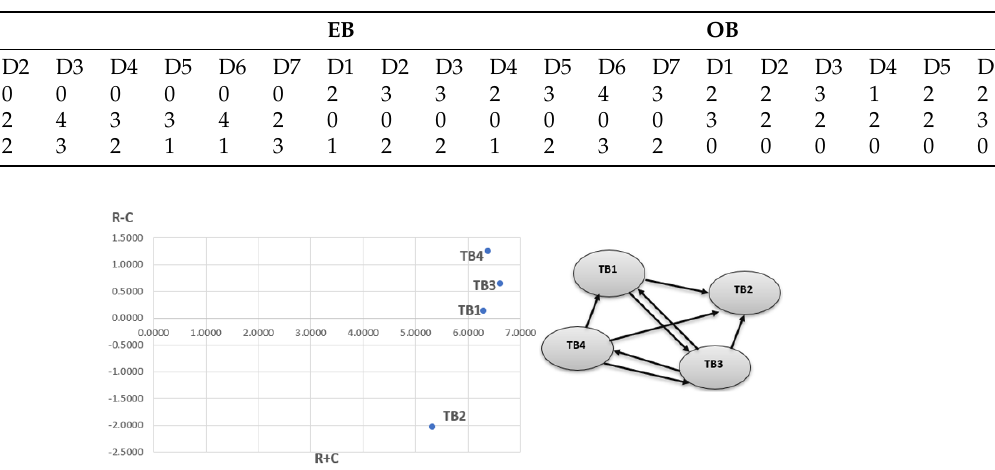
Table A10. The initial direct-relation matrix for main barriers using influence scores of Table 3.